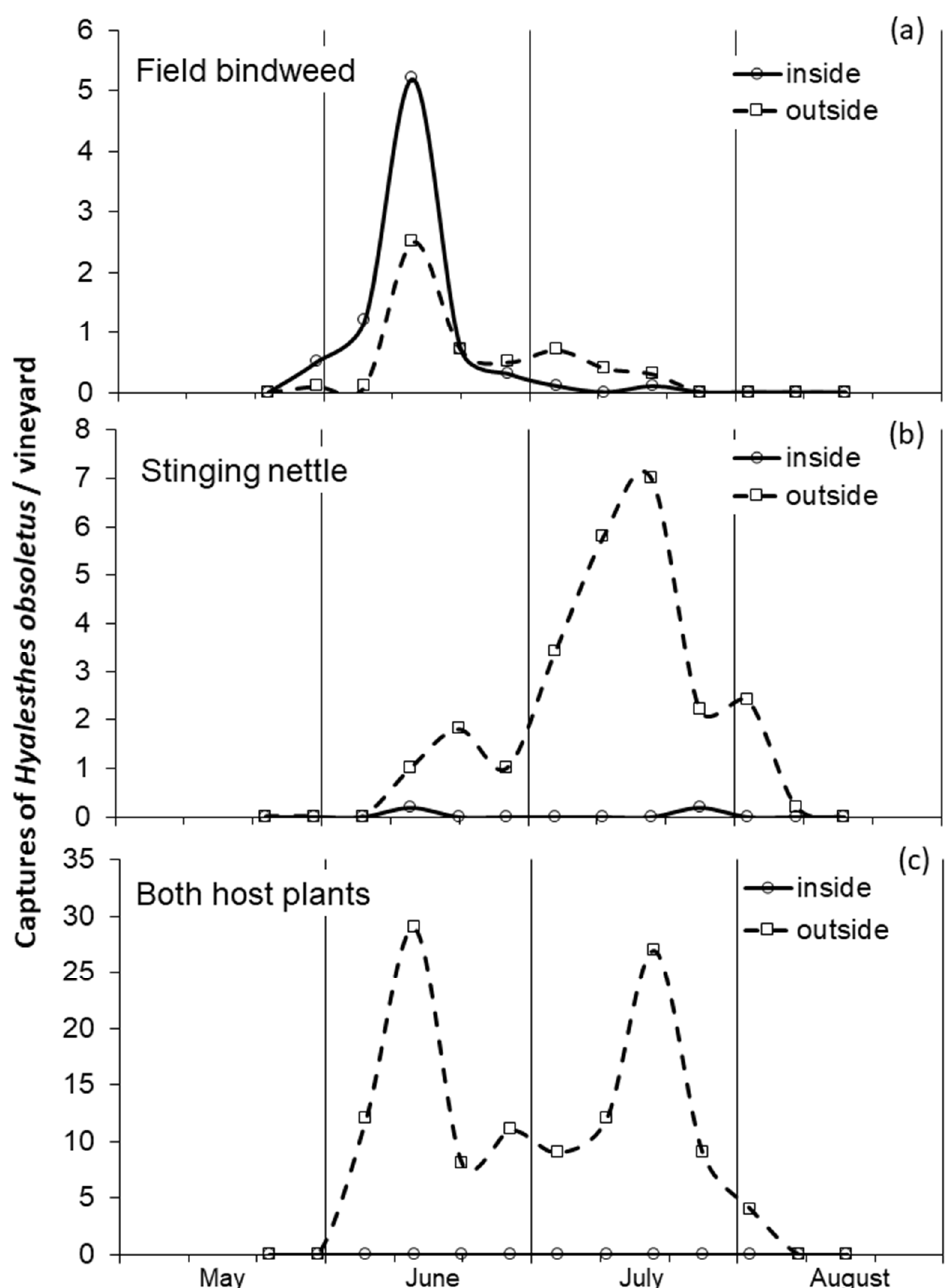
Figure 1. Dynamics of captures of Hyalesthes obsoletus recorded during 2007 in Emilia-Romagna region: ( a ) in two vineyards with the exclusive presence of field bindweed; ( b ) in two vineyards with the exclusive presence of stinging nettle; ( c ) in one vineyard with both host plants. Adults were sampled both inside and outside vineyards.